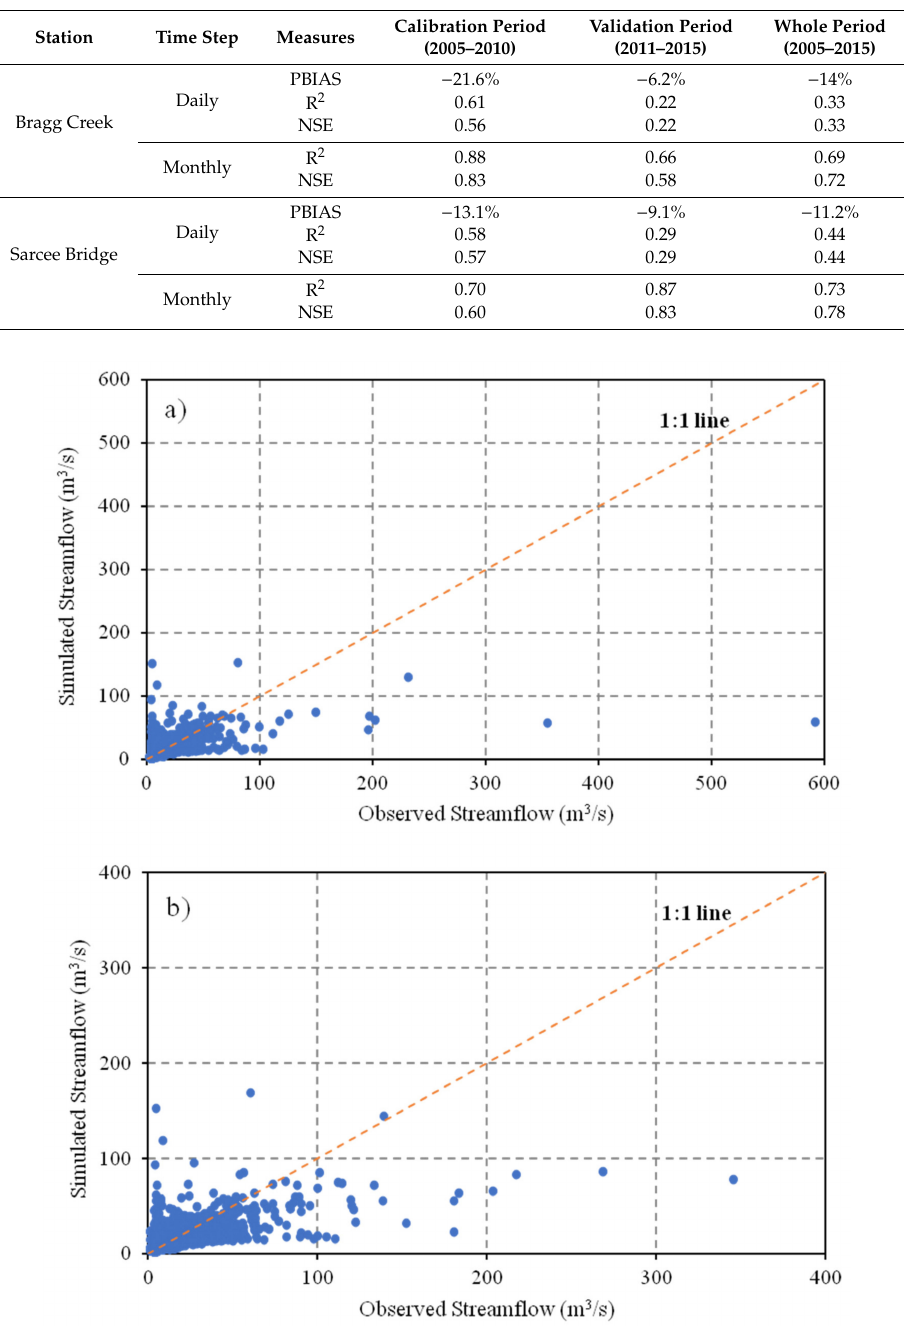
Table 1. Daily and monthly streamflow simulation performance statistics in the Elbow River watershed (ERW).